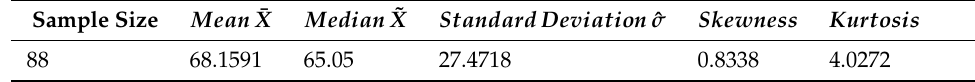
Table 15. Summary statistics in relation to data-III.